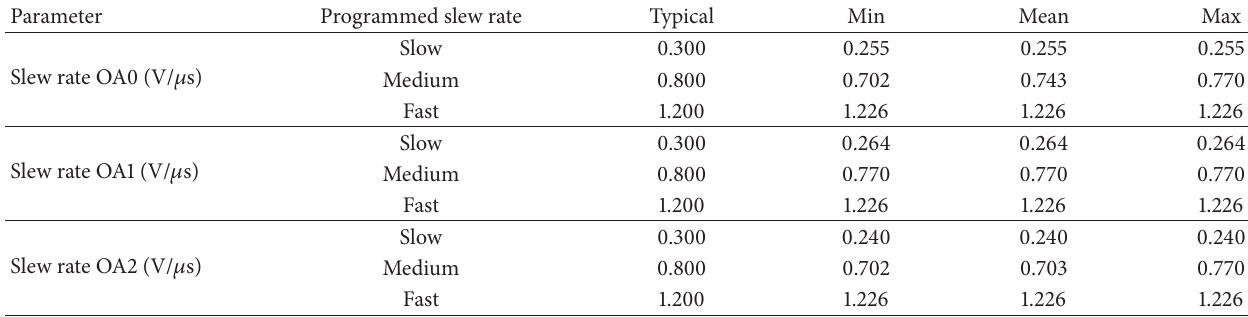
Table 6: Slew-rate test experimental results.